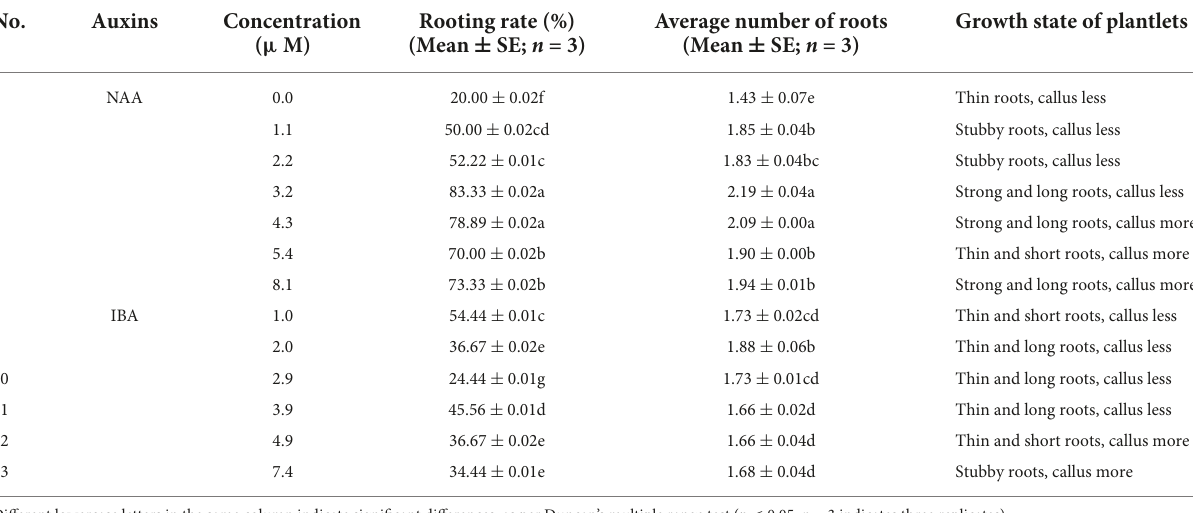
TABLE 5 Effects of different types and concentrations of auxin on rooting.